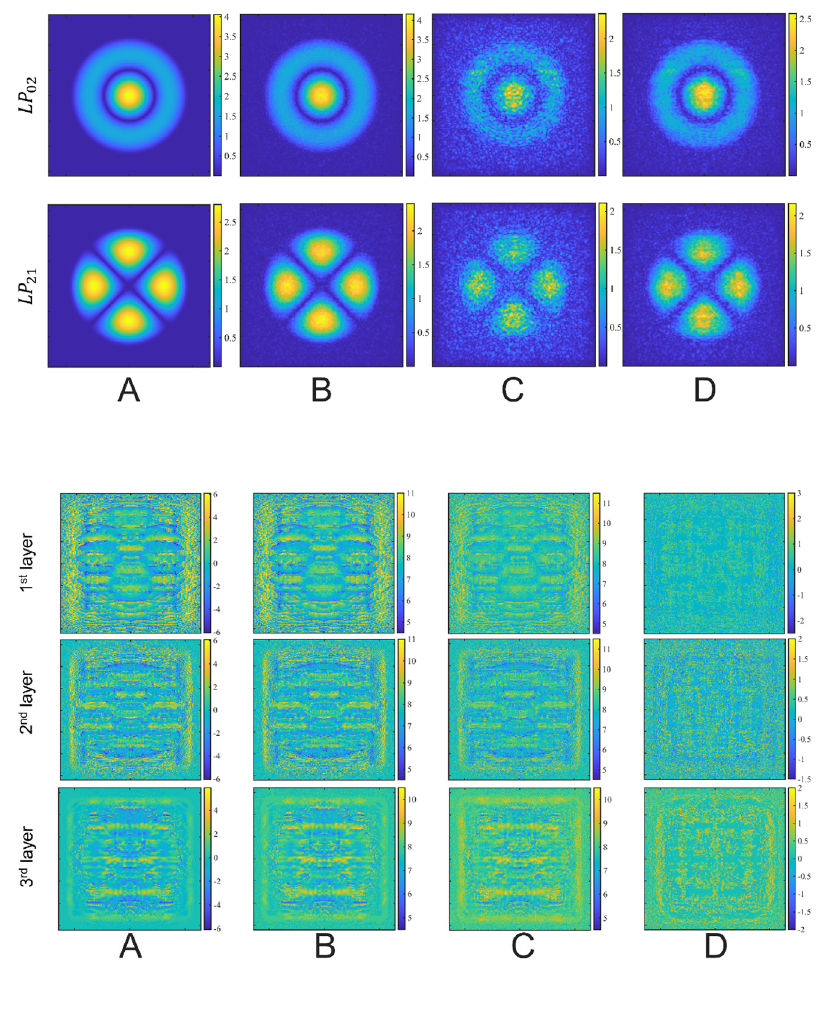
Figure 6: (A) The phase distribution of each layer of the 3-layer phase mask stack (colorbar represents phase in radians). (B) Direct thickness conversion from phase masks. (C) Optimization on thickness distribution by LT, (D) the difference betweenBand C. Colorbarsfor B,C, D show thickness in micrometers and all windows are 128 μ m by 128 μ m.